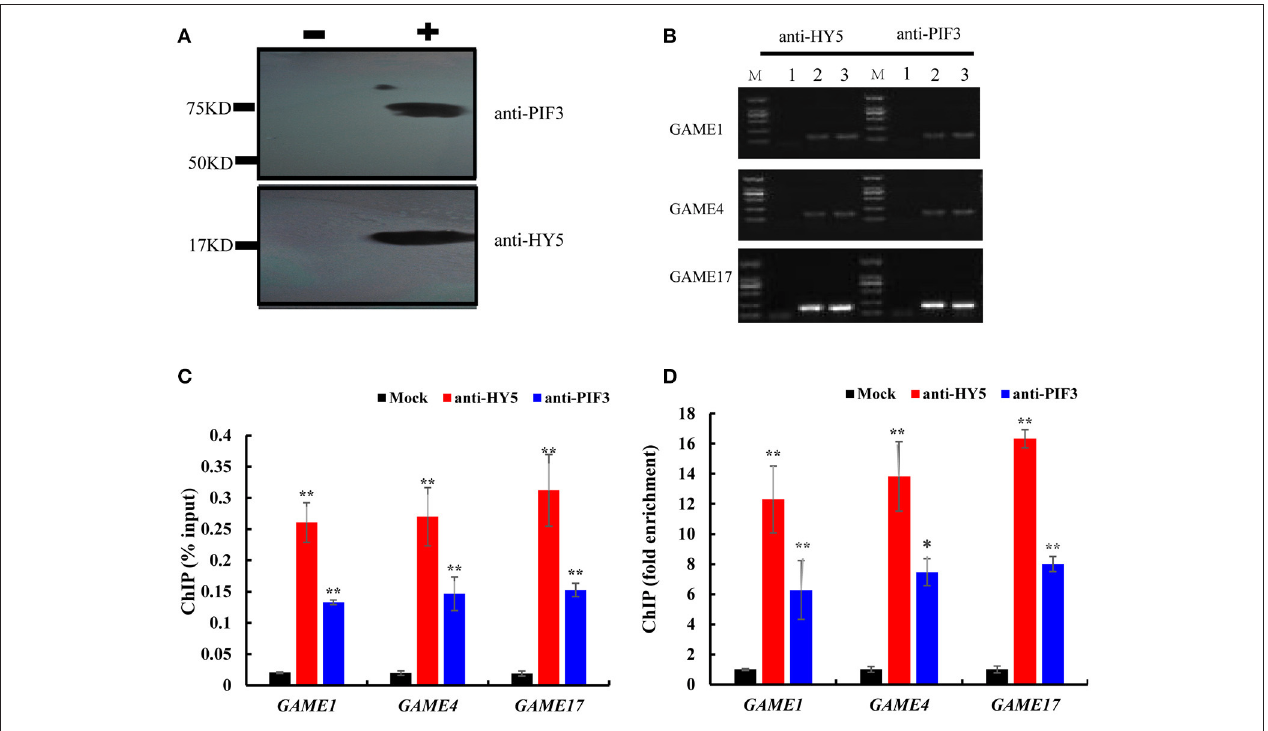
FIGURE 7 | Chromatin immunoprecipitation reveals direct binding of HY5 and PIF3 to the promoters of genes involved in SGA metabolism. (A) Western blot to determine the quality of the polyclonal antibodies against plant proteins. – indicates negative serum; + indicates polyclonal anti-PIF3 and anti-HY5 respectively. (B) Agarose gel electrophoresis analysis of bound sequences through quantitative real-time PCR. 1. Chromatin extract precipitated without antibody (mock). 2. Chromatin extract (input). 3. ChIP with antibodies (anti-HY5 and anti-PIF3, respectively). Analyzed target genes are listed to the left of the corresponding images. (C) The input percentages derived for different antibodies. The columns represent the average input percentage from three independent experiments. (D) Quantification of ChIP analysis corresponding to images presented in (C) . Ordinates show the fold